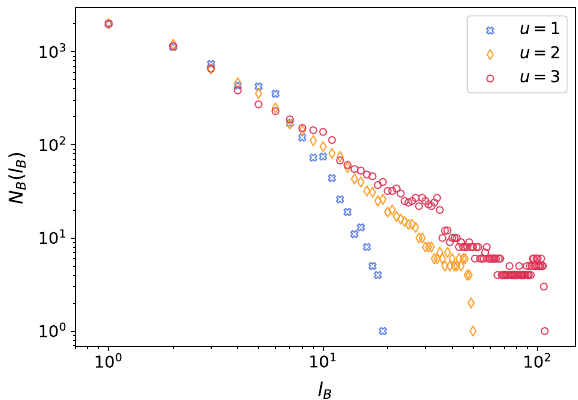
Fig. 7 Illustration of the fractality of the ( u , v )‑flower for different parameter settings. In all of the cases, the iteration number is set to four, and w = 7 is also